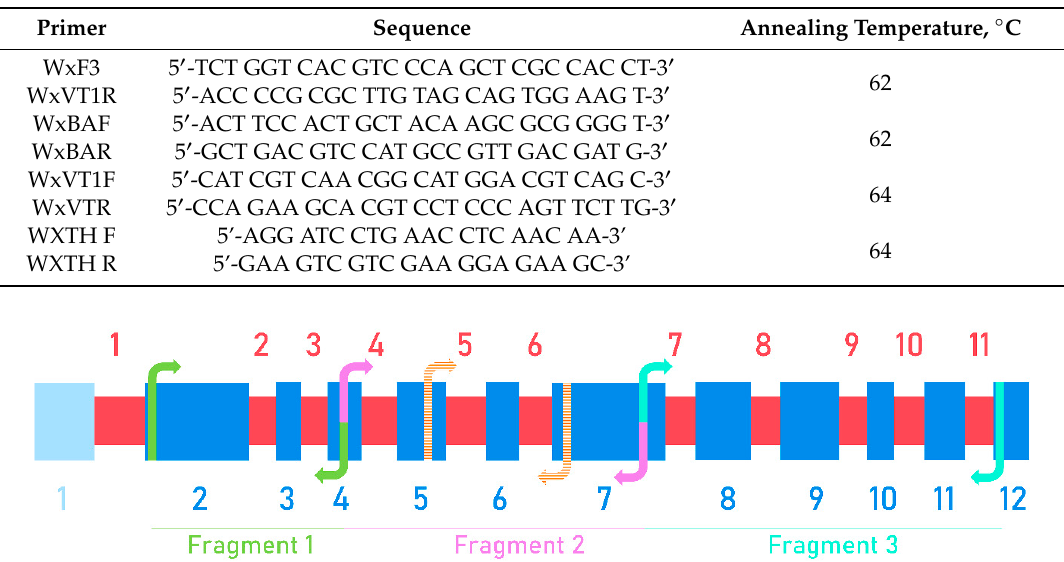
Table 1. Primers used for cloning Wx genes of the studied wild grasses (taken from [74]) and WXTH primers developed in the present study for the identification of Wx genes-orthologs of the studied wild grasses in the wheat background.